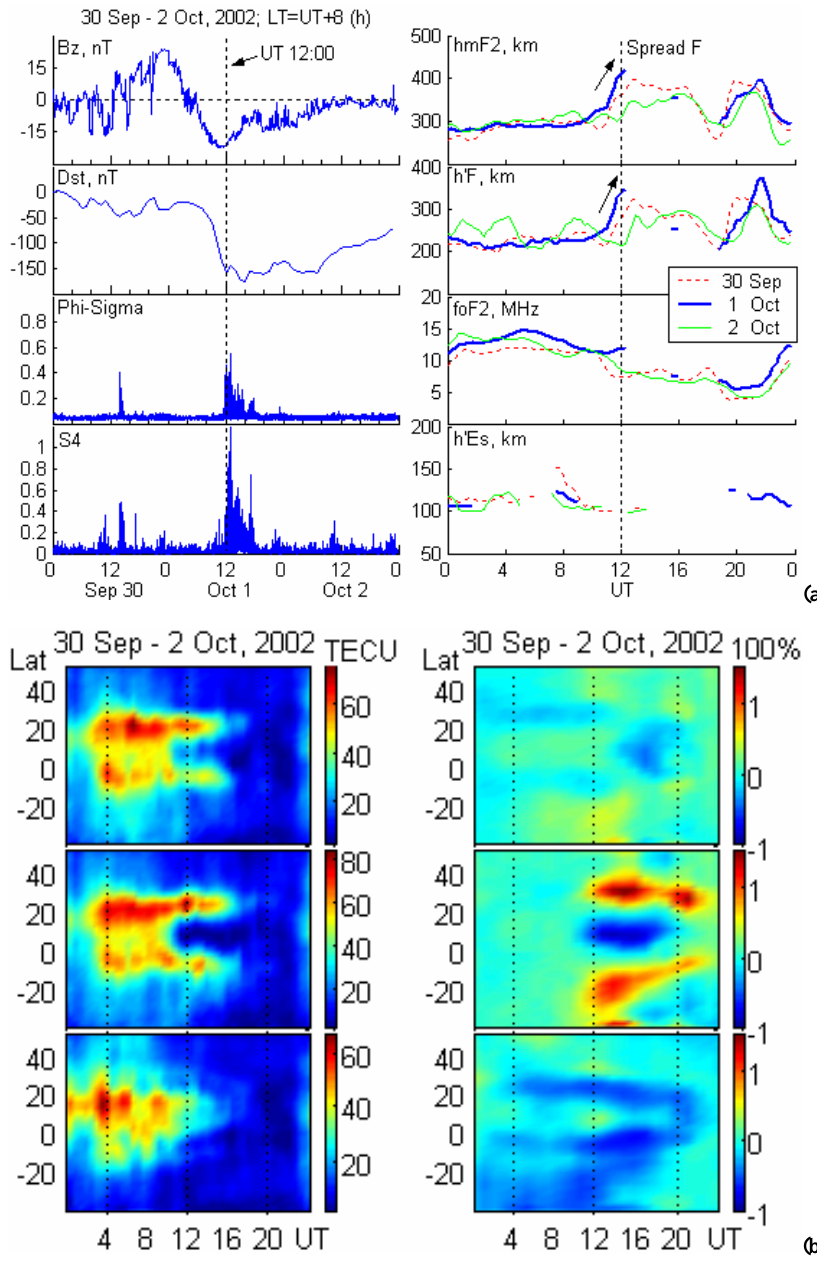
Fig. 2. (a) B z component of the interplanetary magnetic field in geocentric-solar-magnetospheric (GSM) coordinates provided by the Ad- vanced Composition Explorer (ACE) spacecraft (top panel, left) and D st index (middle panel, left) obtained from CDAWeb and SPIDR; Phase scintillation index (Phi-Sigma, middle panel, left) and Amplitude scintillation index (S4, bottom panel, left) measured from all GPS satellite signals observed at Wuhan; F layer peak height ( hm F2, top panel, right), F layer virtual height (h 0 F, middle panel, right), F layer critical frequency ( fo F2, middle panel, right) and sporadic E layer virtual height (h 0 Es, bottom panel, right) obtained from Digisonde mea- surements at Wuhan for the period 30 September–2 October 2002. (b) Latitudinal variation of TEC along geographic longitude 110 ◦ E for 30 September (top panel, left), 1 October (middle pane, left), 2 October (bottom panel, left), 2002, and RTEC along geographic longi- tude 110 ◦ E for 30 September (top panel, right), 1 October (middle pane, right), 2 October 2002 (bottom panel, right), show the equatorial ionization anomaly (EIA)